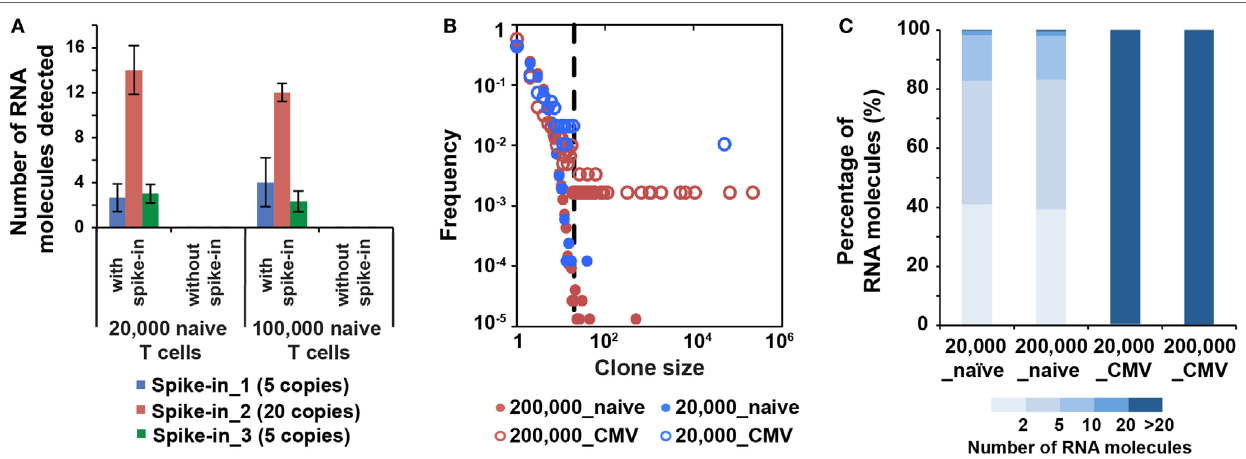
FIGURe 4 | MID Clustering-based IR-Seq is sensitive to detect both low copy and highly clonal expanded T cell receptors (TCRs). (A) Number of RNA molecules detected by sequencing for each spike-in TCR control sequences (the numbers in the legend denote copies of each TCR spike-in control sequence added). (B) Comparison of clone size distribution in naïve CD8 + T cells and CMVpp65-specific effector CD8 + T cells (dashed line indicates TCR sequences with 20 copies of RNA molecules). (C) The percentage of RNA molecules that varying degree of clonally expanded complementarity-determining region 3 account